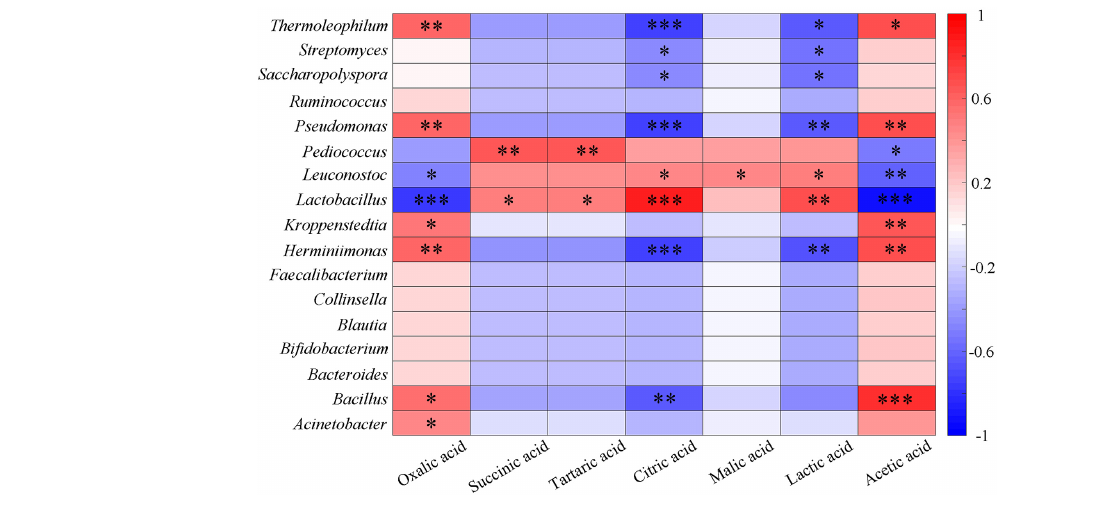
Frontiers in Microbiology |